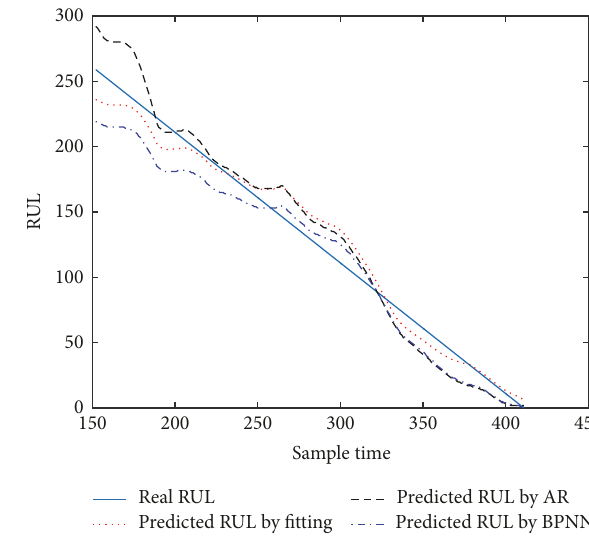
Figure6:ThefittedRULpredictionmodelofthecriticalcomponent based on DCA. Table 3: Mean of RUL prediction error.